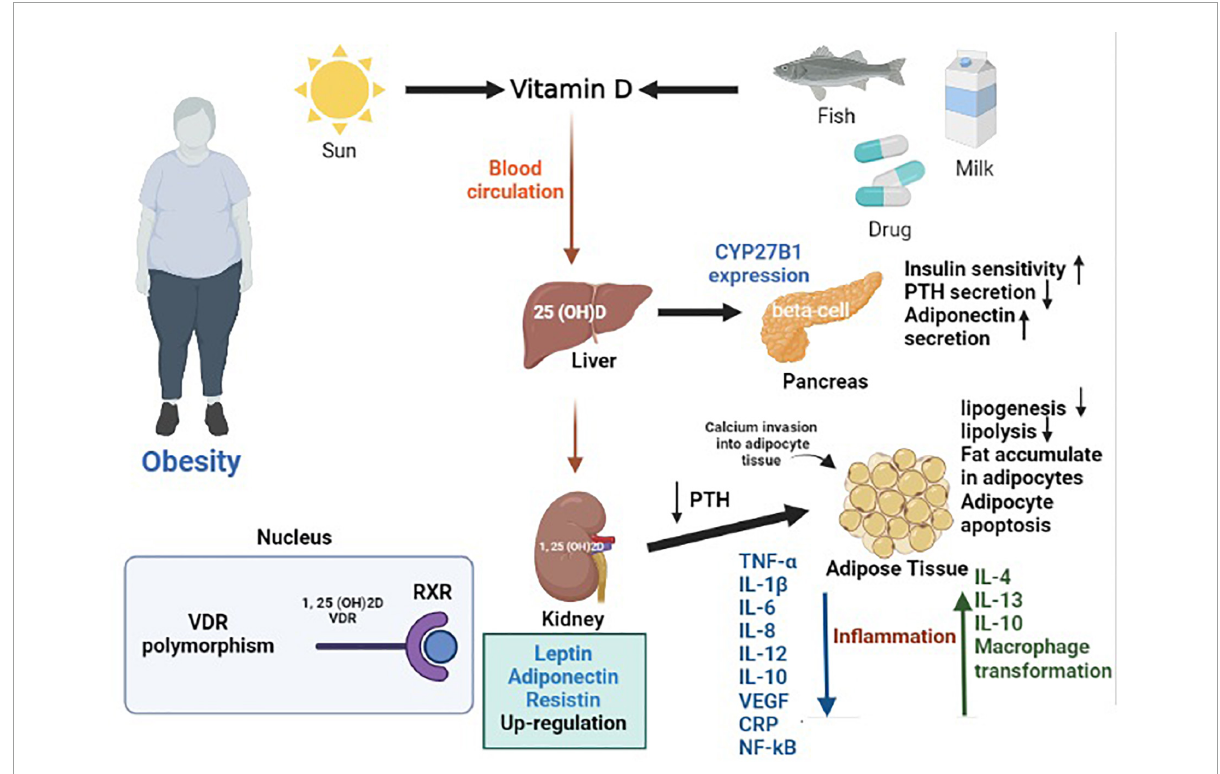
FIGURE5 The mechanism of action of vitamin D in